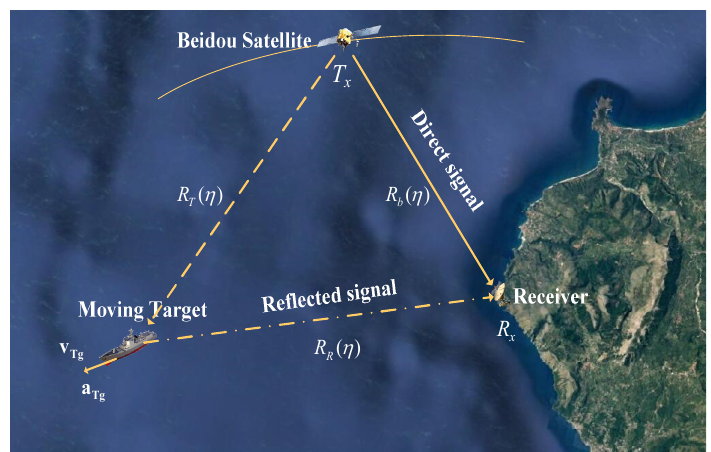
Figure 1. Reference surveillance